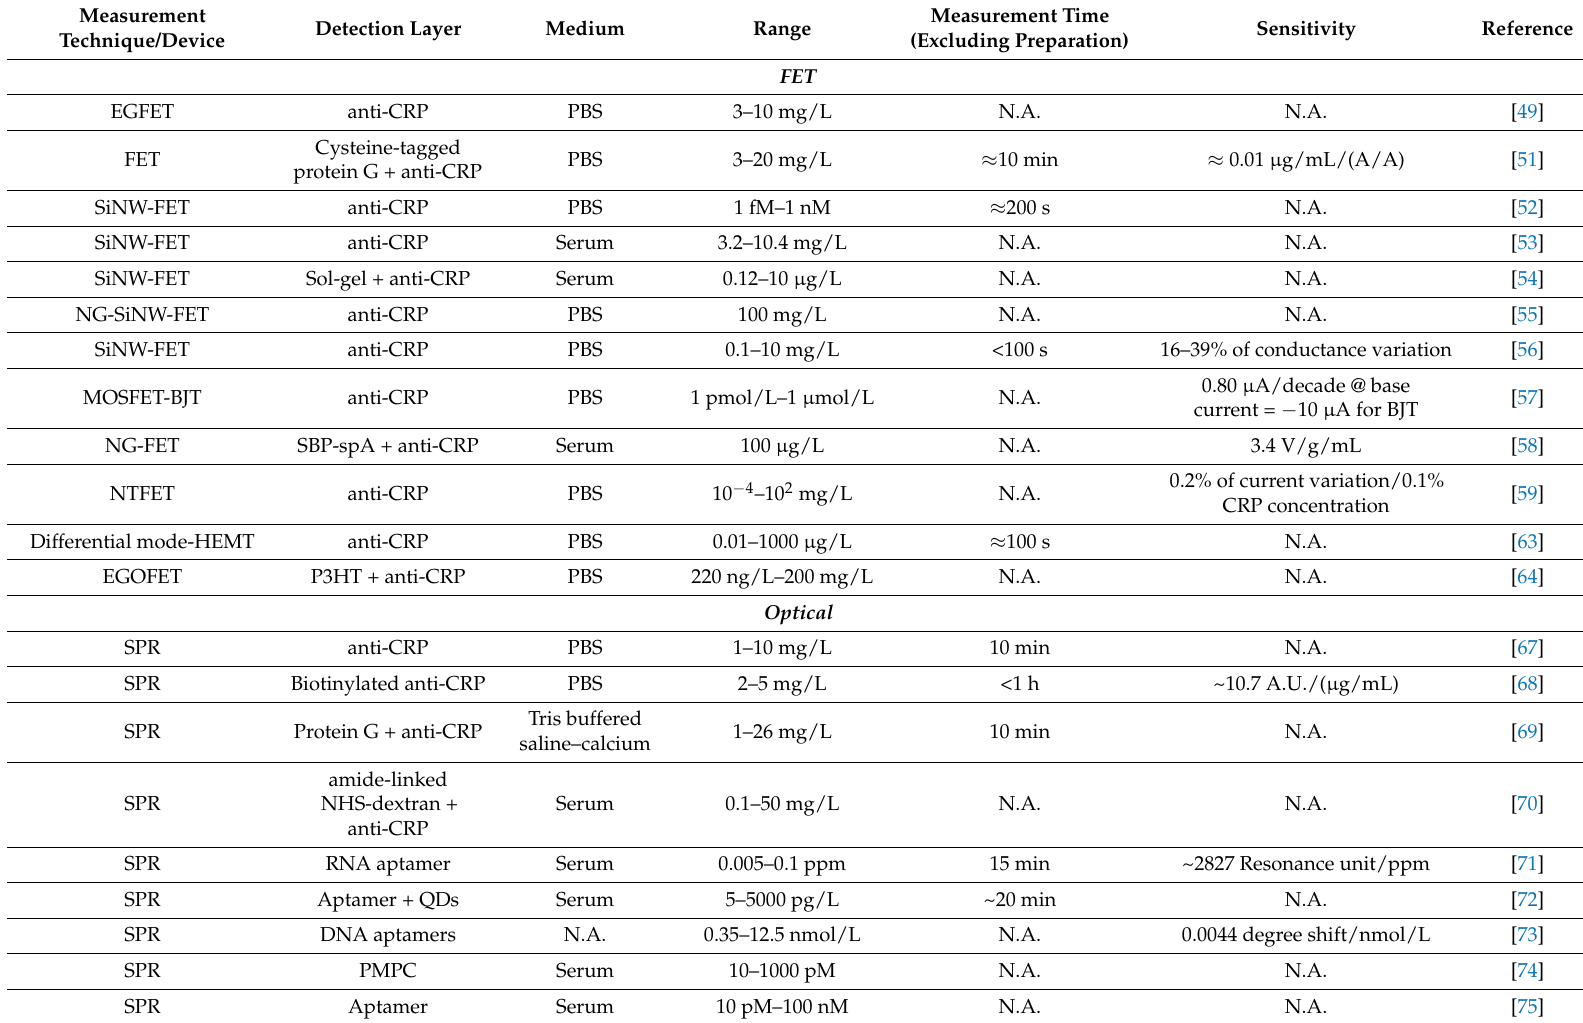
Table 1. Analytical characteristics for different CRP biosensors reported in the literature (N.A. not